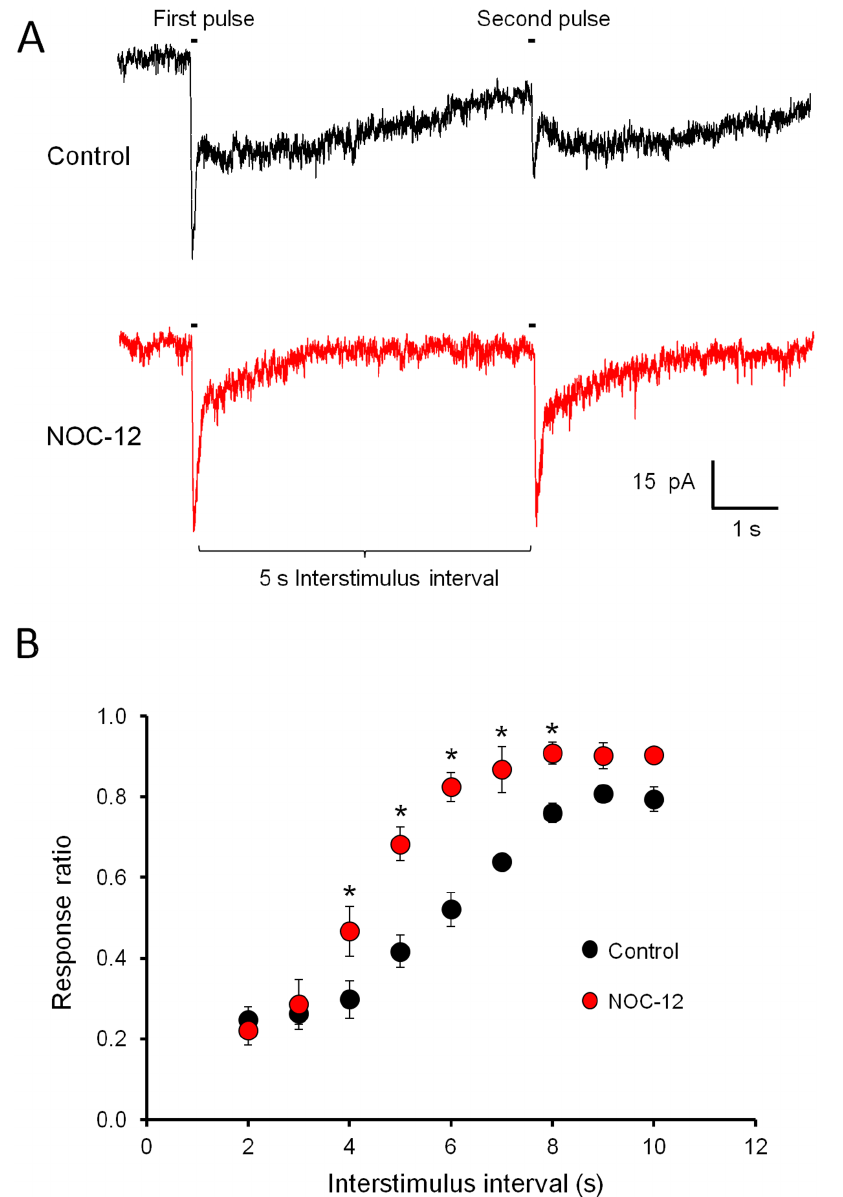
Figure 5. Response recovery during repetitive stimulation is accelerated by NO. (A) Comparison of the recovery of the amplitude of the fast, kainate receptor-dependent component of the glutamate response after two consecutive stimuli (100 ms) with a 5 s interstimulus interval. While reducing the duration of the slow component of the glutamate response, NOC-12 strongly amplified the fast response to the second glutamate stimulus. (B) Amplitude changes of the fast component of the glutamate response at different inter-stimulus intervals in absence and presence of NO donor. The recovery of the kainate receptor-dependent response is significantly accelerated by exogenous NO at intermediate interstimulus intervals (4–8